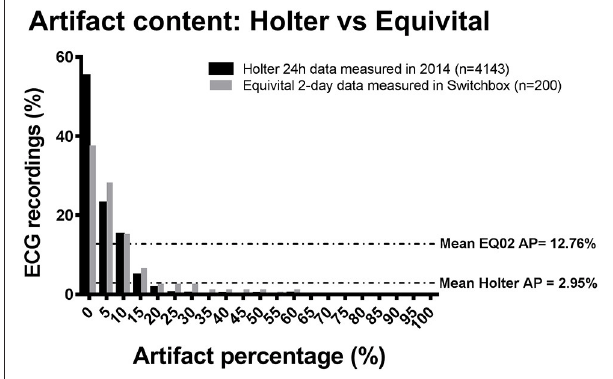
FIGURE 6 | Comparison of artifact content of raw Holter data to raw EQ02 data. Bar chart showing content and distribution of artifact in raw (uncleaned) 24 h Holter ECG recordings from 4143 subjects with raw EQ02 data from 200 subjects. The average artifact percentage from the